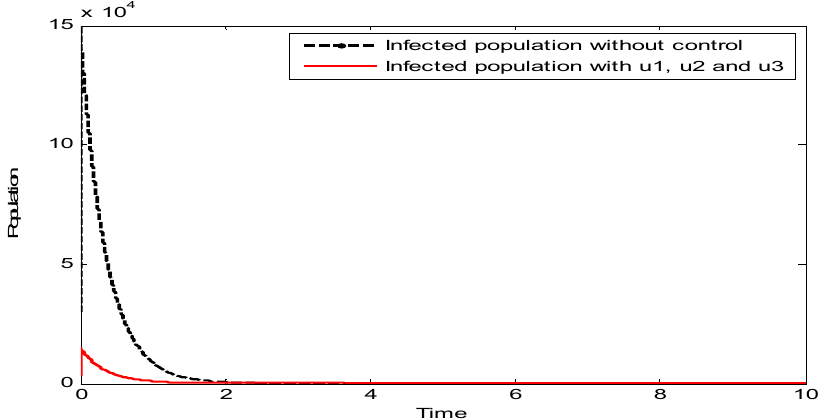
Figure 9. Comparing the dynamics of the infected population without control and with control u 1 , u 2 & u 3 .